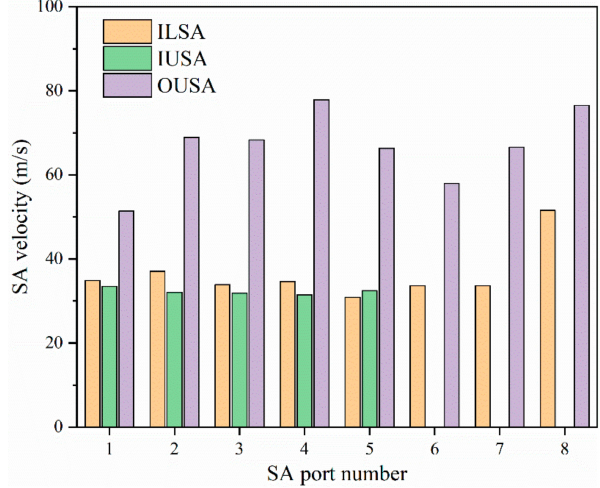
Figure 4. Velocity distributions of SA ports at the non-uniform SA cases.